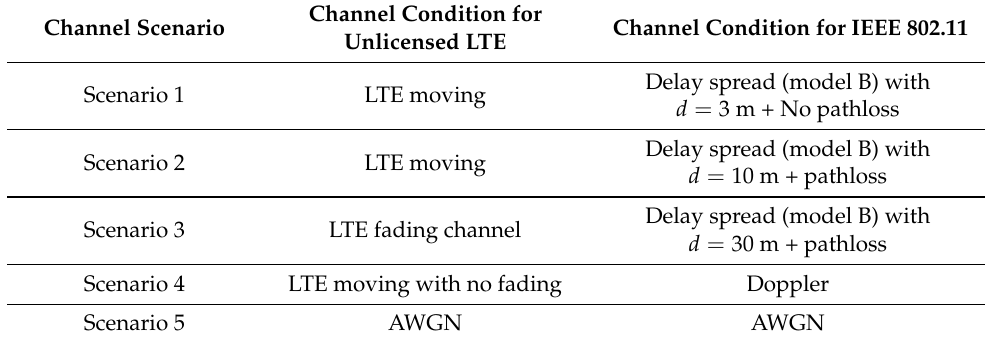
Table 1. Channel scenario based on LTE and IEEE 802.11 channel